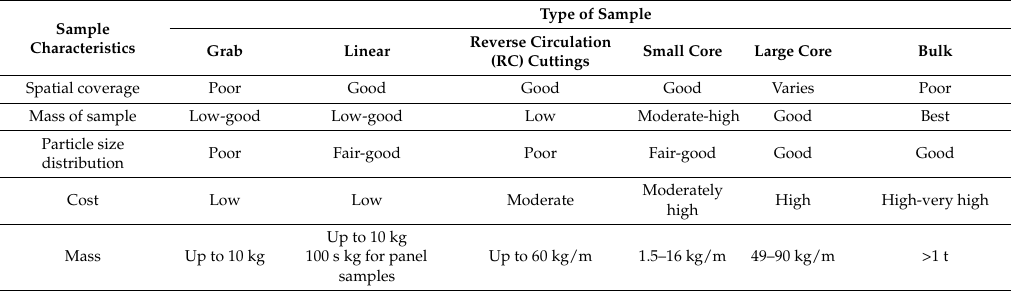
Table 12. Characteristics of sample types (modified from [17]).